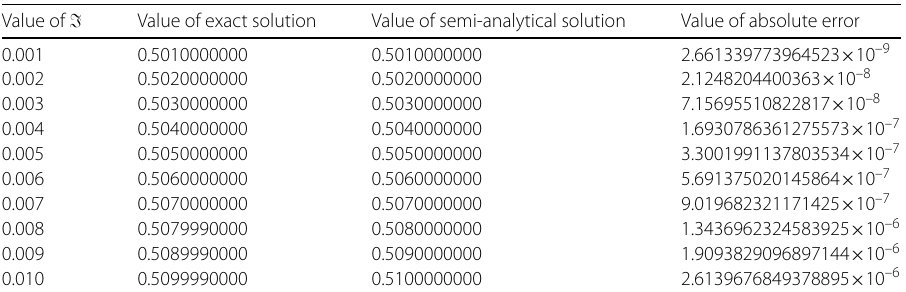
Table 1 Comparison between analytical and semi-analytical solutions of the Cahn–Allen equation to calculate the values of absolute error, which explains the accuracy of both kinds of solutions Value of (cid:6) Value of exact solution Value of semi-analytical solution Value of absolute error 0.001 0.5010000000